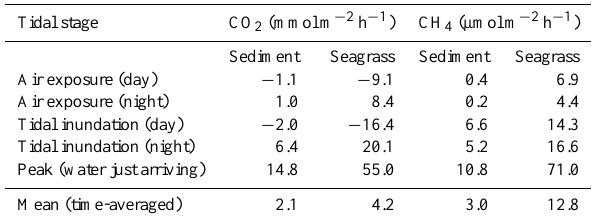
Figure 2. Diurnal variations of the CH 4 and CO 2 fluxes above a meadow of the seagrass Z. noltii . Light intensity is also shown. The measurements were carried out from 25 to 28 April 2012. Yellow bars indicate daylight periods, green bars indicate periods of air ex- posure, and blue bars indicate periods of tidal immersion.